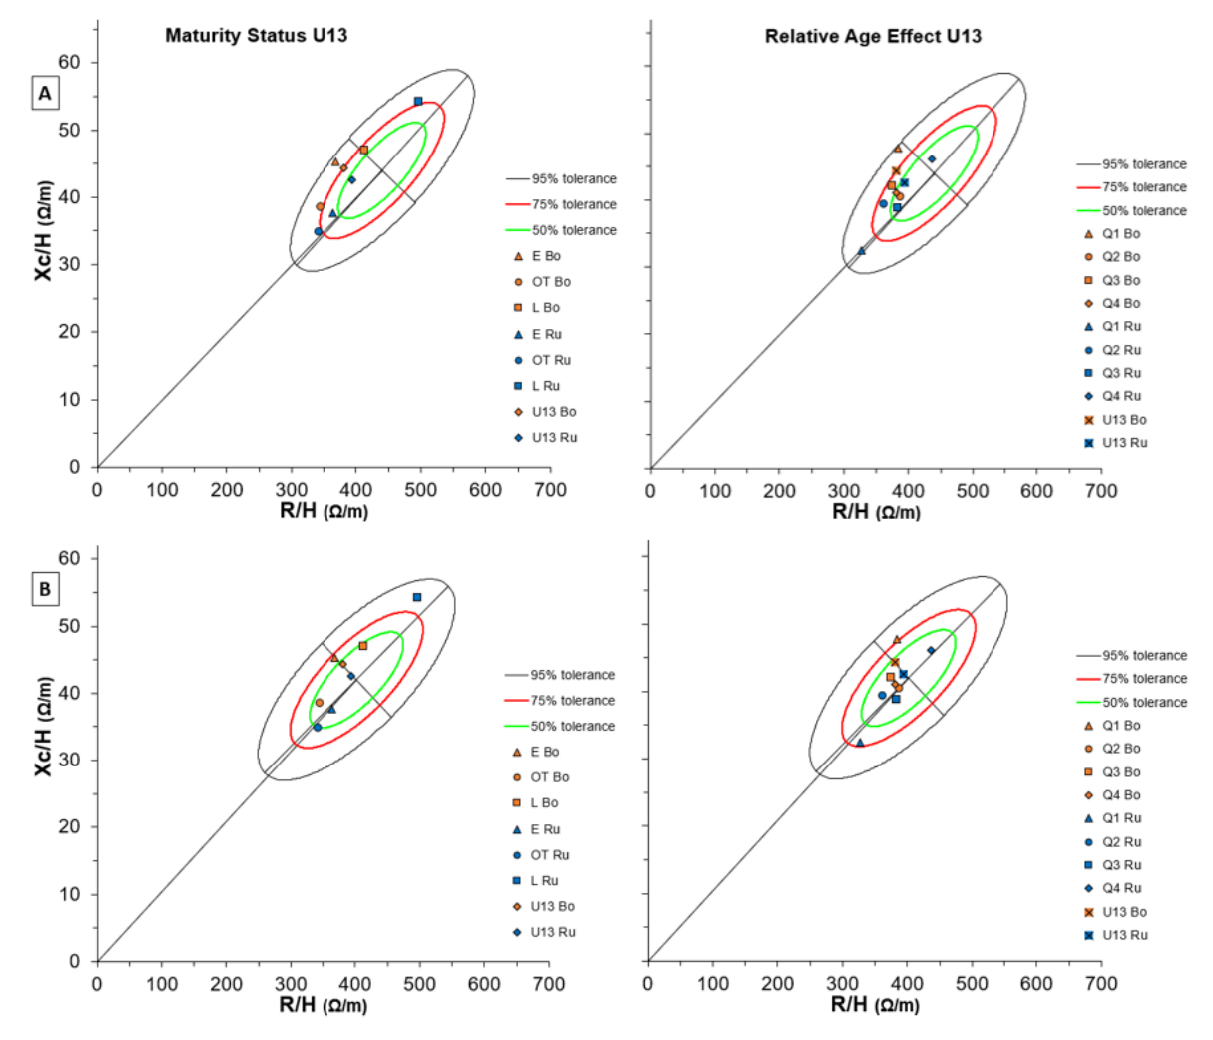
Figure 7. BIVA tolerance with Maturity Status (left) and Relative Age Effect (right) of both Bologna and Russi U13 groups for two reference populations: ( A ) number 114 (males, white, age 12 years, BMI 18, Italy, Akern-RJL Systems); ( B ) number 116 (Males + Females, White, age 13 years, BMI 19, Italy, Akern-RJL Systems). Note: U15 Bo and U15 Ru refer to team means, respectively.